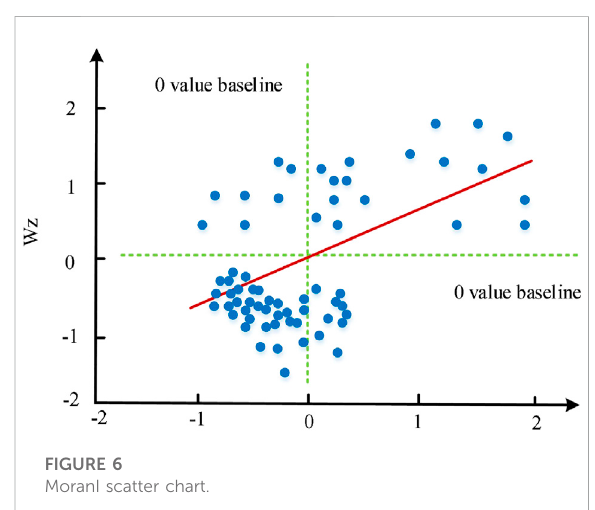
FIGURE 6 MoranI scatter